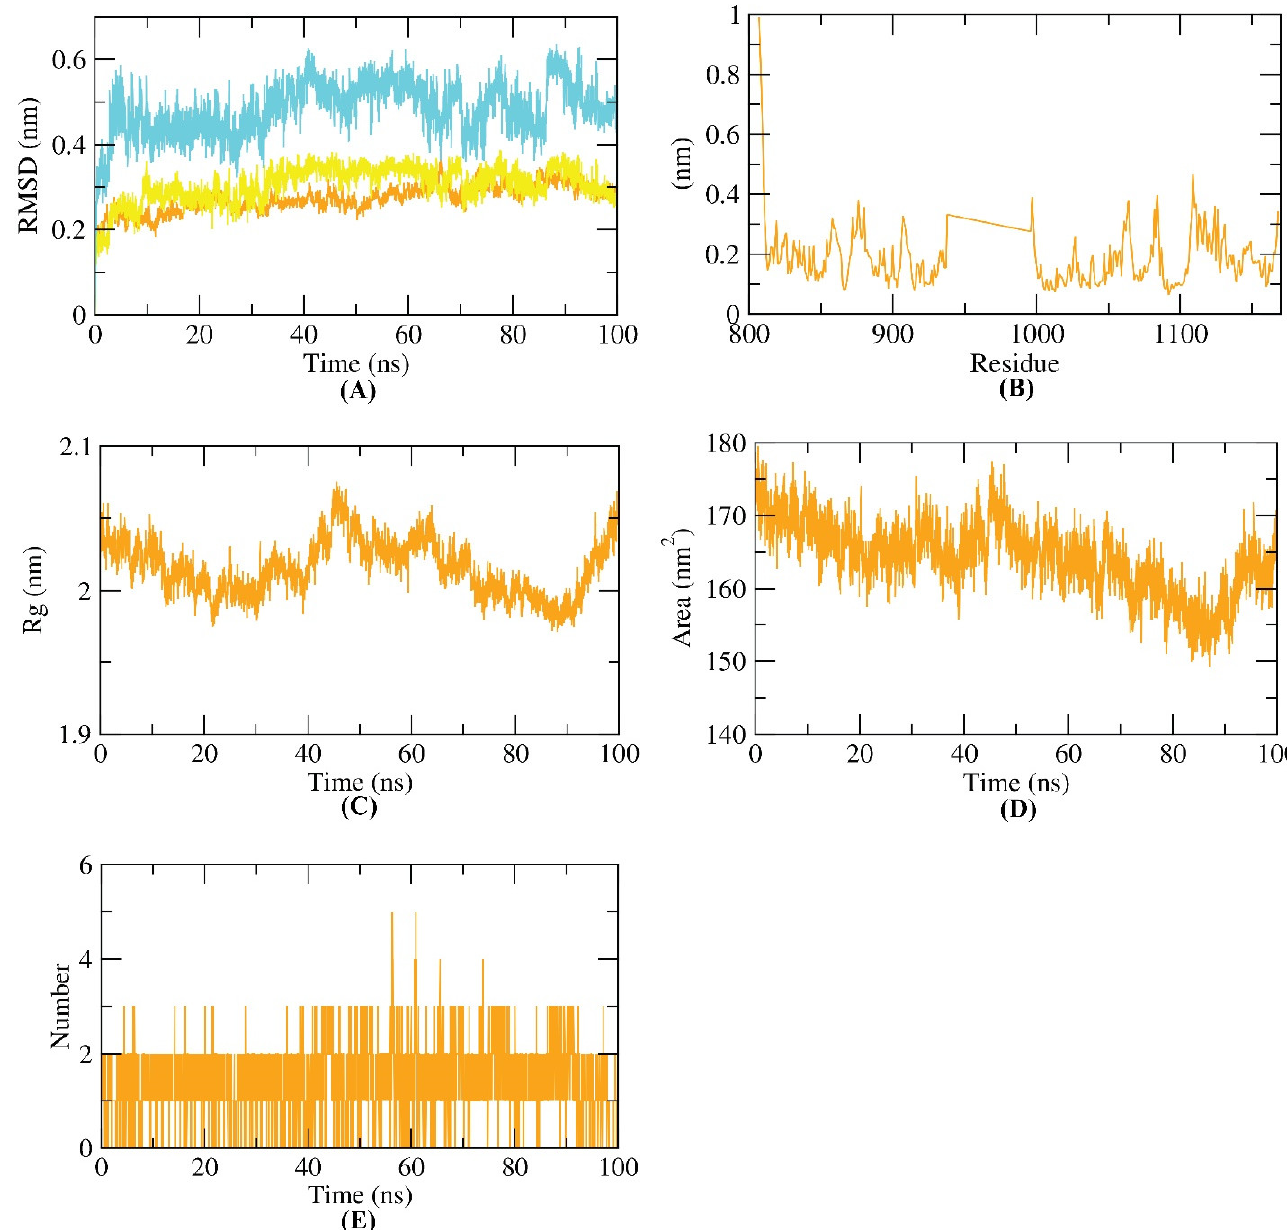
Figure 10. MD simulations. ( A ) RMSD values, ( B ) RMSF, ( C ) R g , ( D ) SASA, and ( E ) H-bonding of VEGFR-2–compound 8 complex. VEGFR-2–compound 8